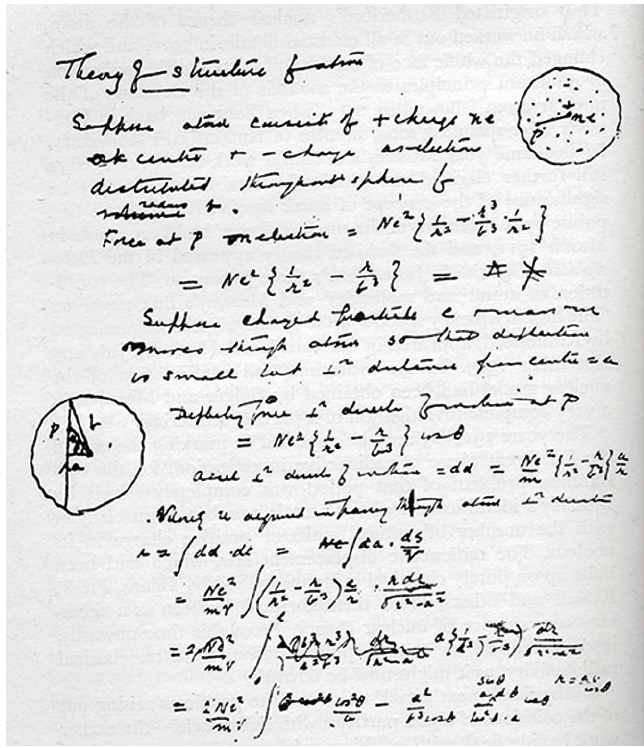
Fig. 1 A page of